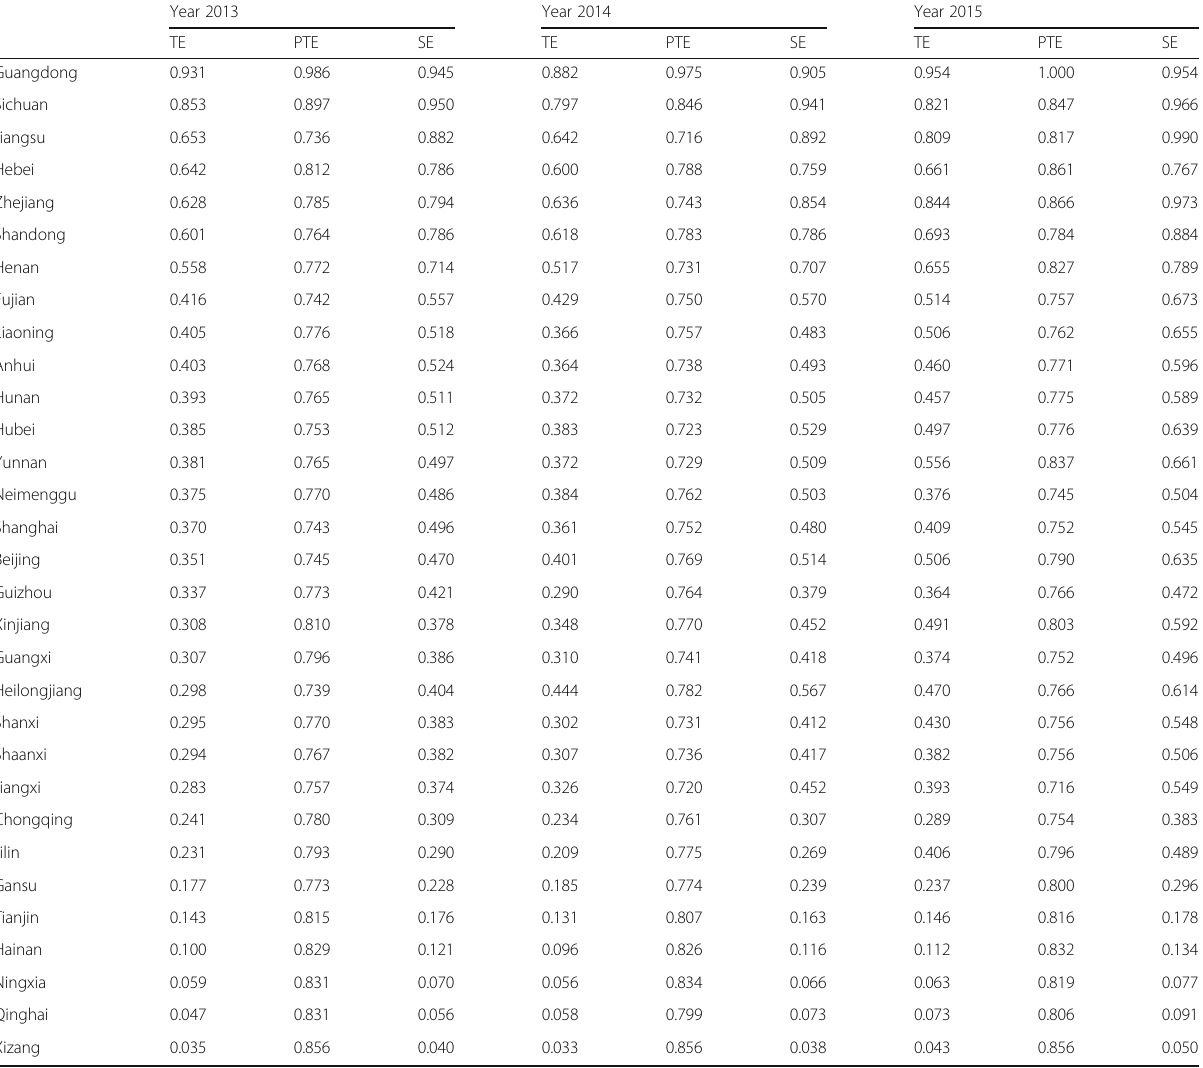
Table 3 The annual average technical efficiency (TE), pure technical efficiency (PTE), and scale efficiency (SE) of 31 provincial companies from 2013 to